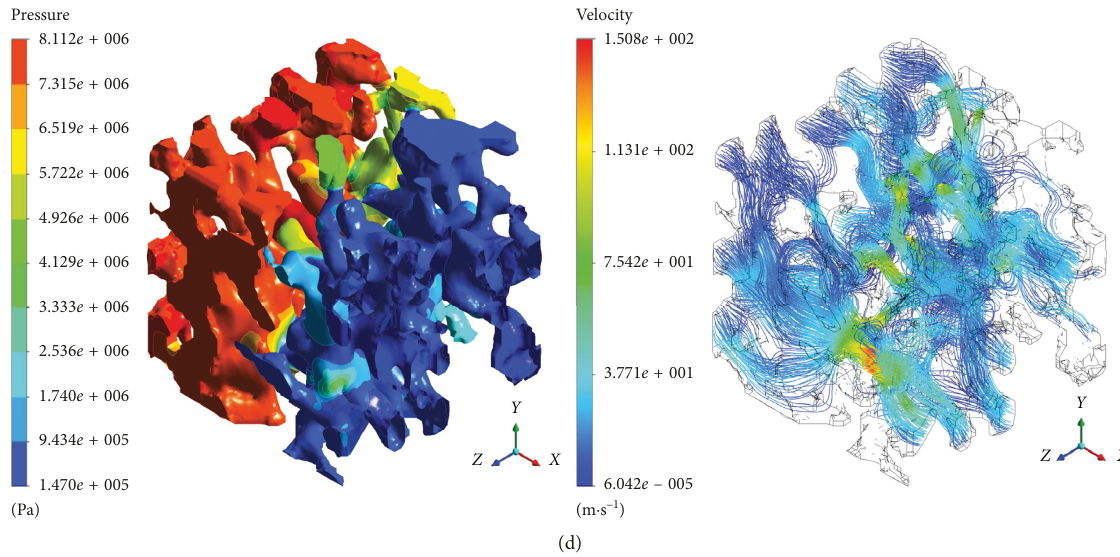
Figure 20: Distribution of pressure and velocity fields in four different models under a medium inlet pressure of 8.1MPa. (a) Results in model P 1 . (b) Results in model P 2 . (c) Results in model P 3 . (d) Results in model P 4